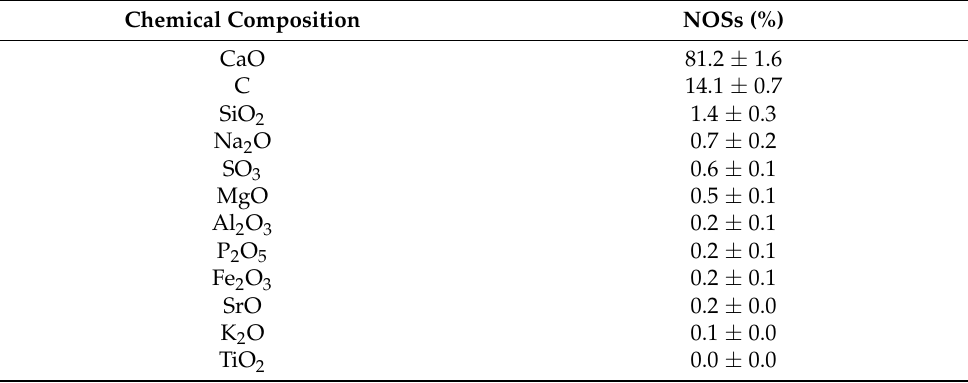
Table 1. Chemical composition of neglected oyster shells (NOSs).